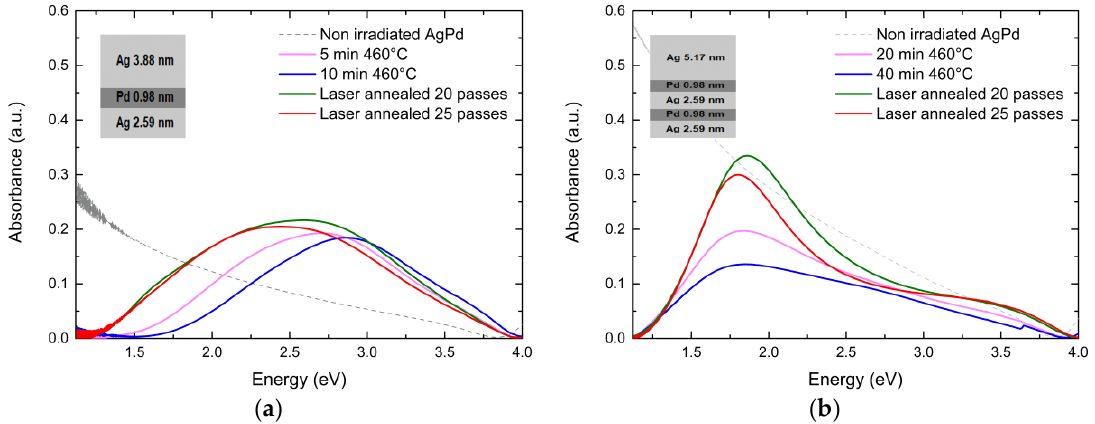
Figure 8. Absorbance spectra of two AgPd multilayers with thicknesses of 7.5 nm (AgPd #1) ( a ) and ( b ) 12.3 nm (AgPd #2). Their compositions are shown in the insets. These multilayers were thermally annealed at 460°C in a furnace in air and laser-annealed for 20 and 25 passes. Detailed data are shown in Table 4.